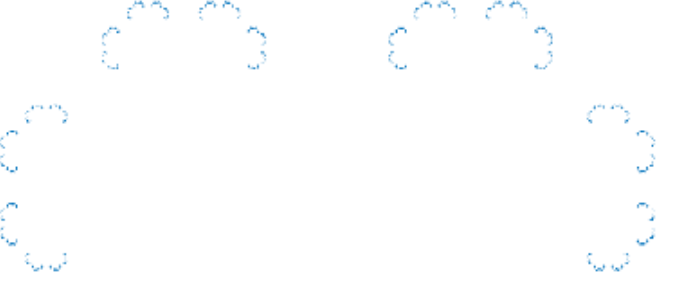
Figure A2. The canopy of T